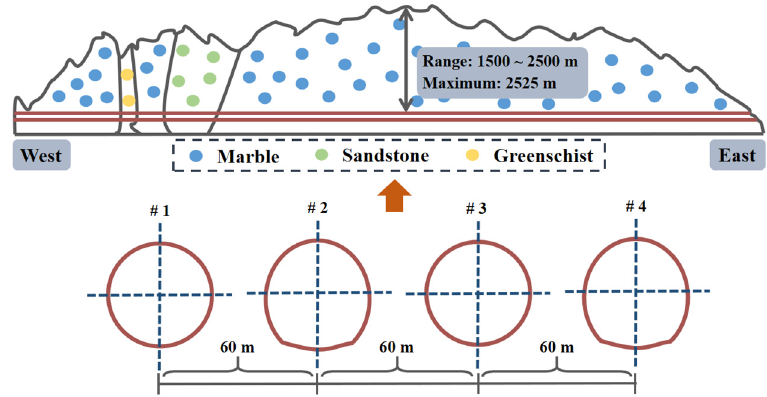
Figure 4. Schematic of the headrace tunnel for the Jinping II hydropower station.